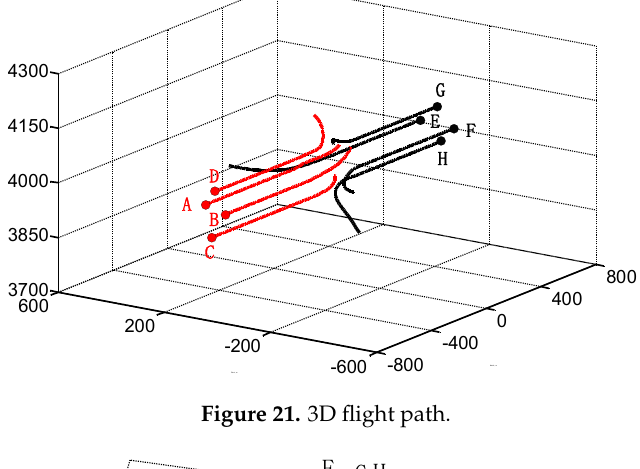
Figure 21. 3D flight path.